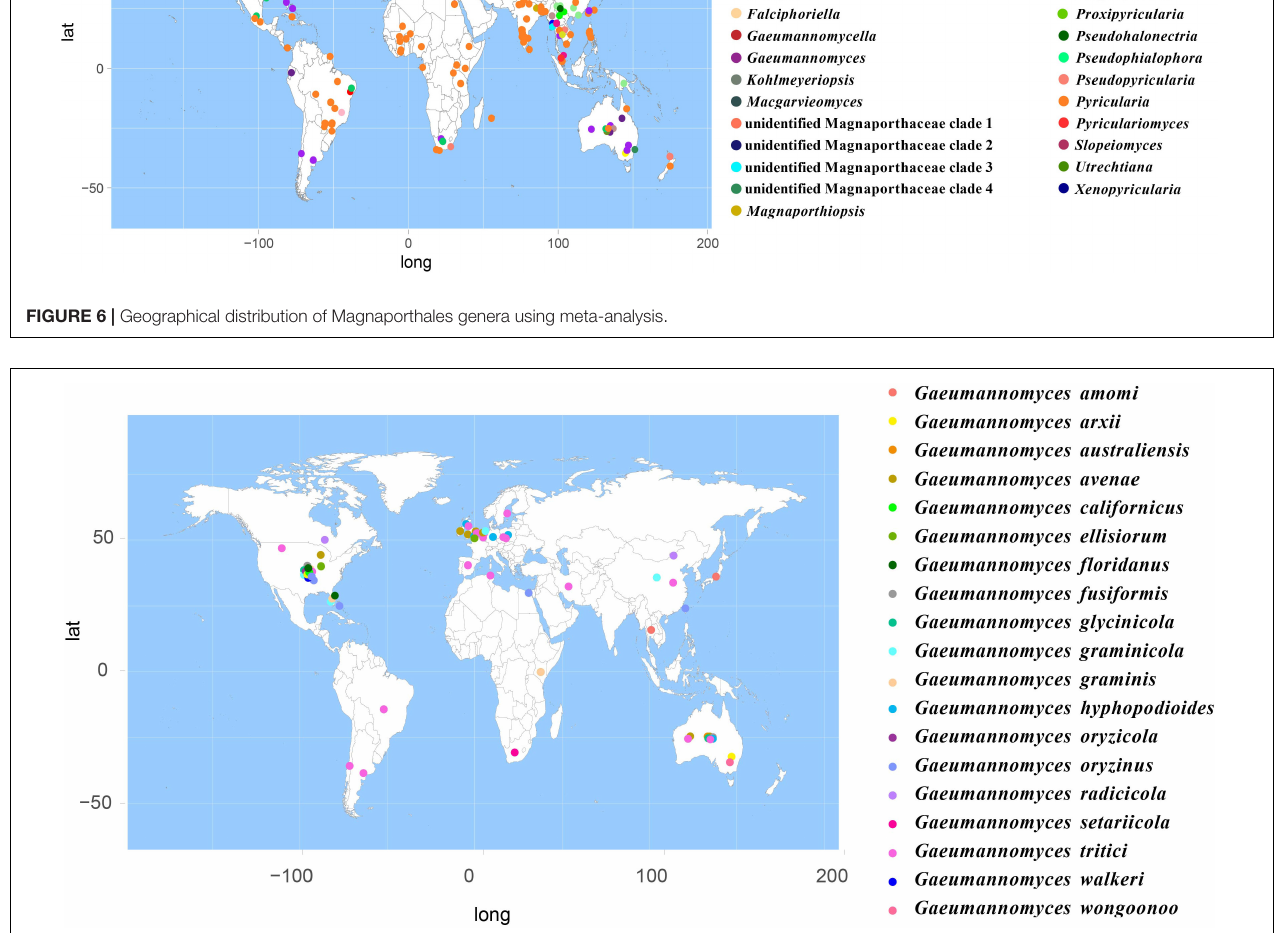
FIGURE 7 | Geographical distribution of Gaeumanomyces using